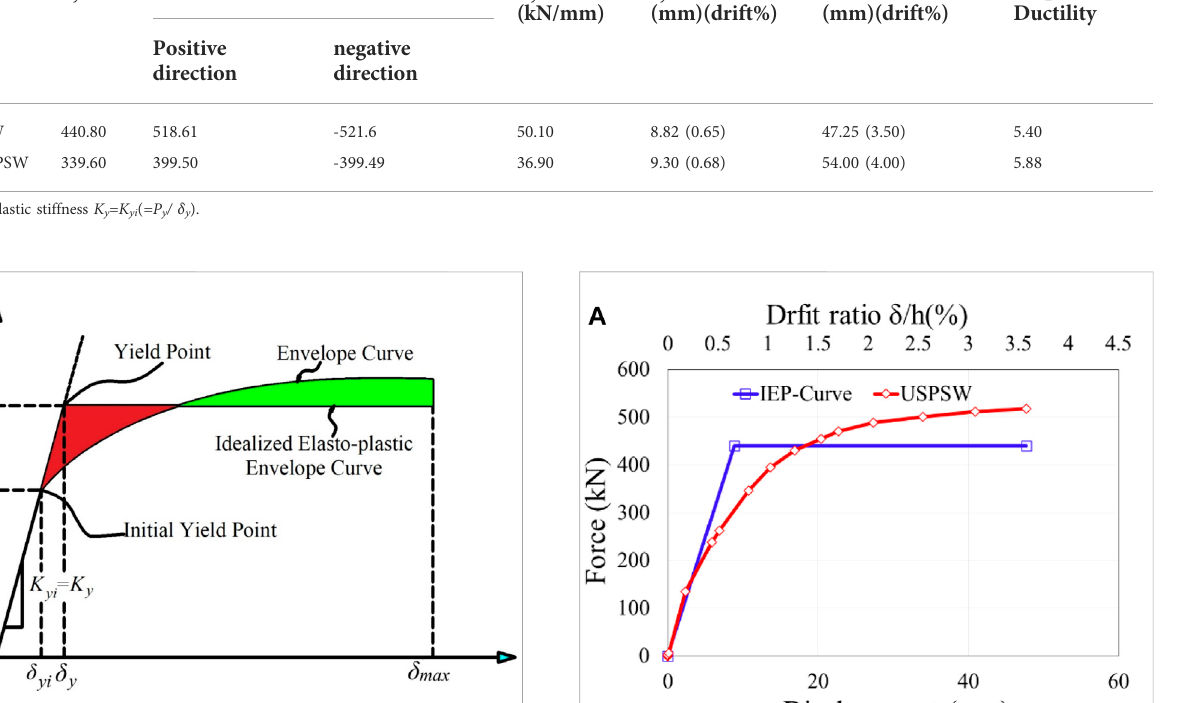
FIGURE 10 Yield point and initial yield point de fi nitions.